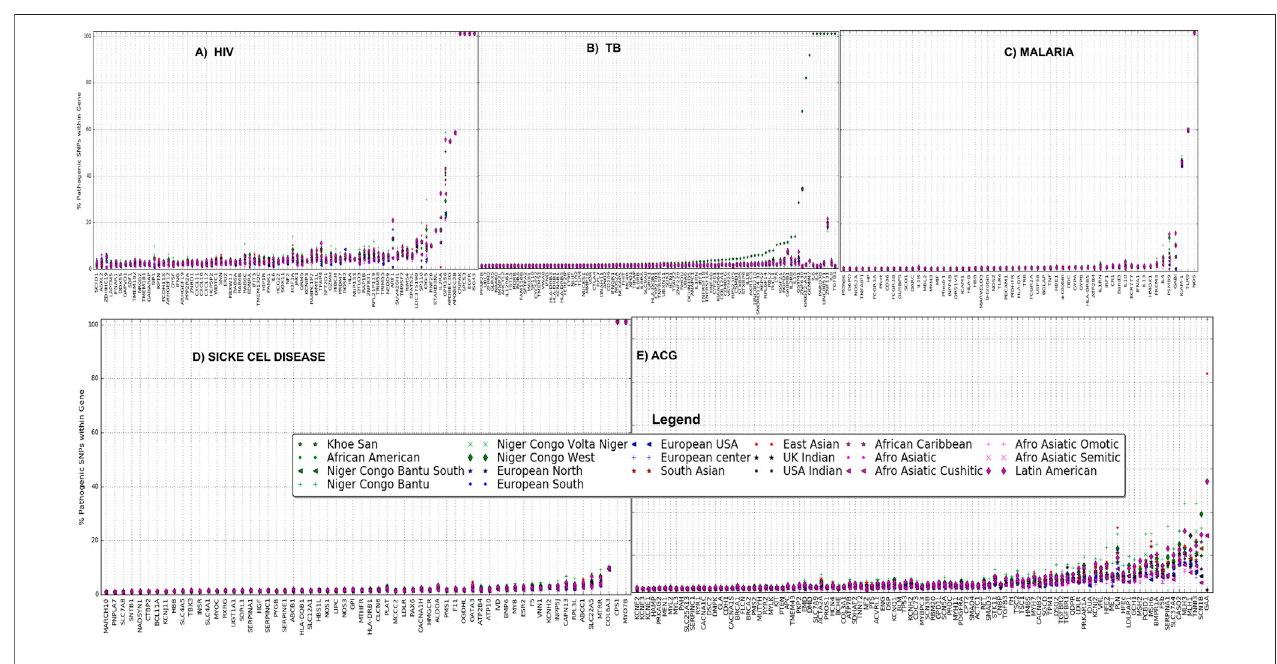
FIGURE 2 | Proportion of pathogenic variants within (A) HIV-speci fi c, (B) TB-speci fi c, (C) malaria-speci fi c, (D) sickle cell disease-speci fi c, and (E) ACG-speci fi c (actionable genes) genes among all 20 ethnolinguistic cultural